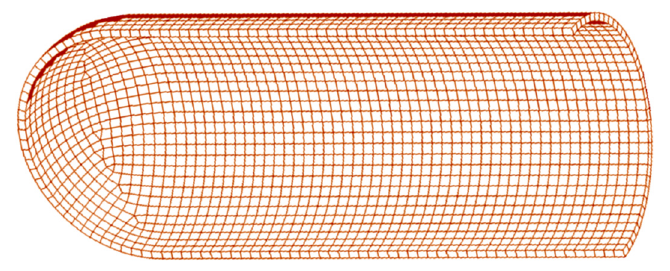
Figure 5. The finite element model.